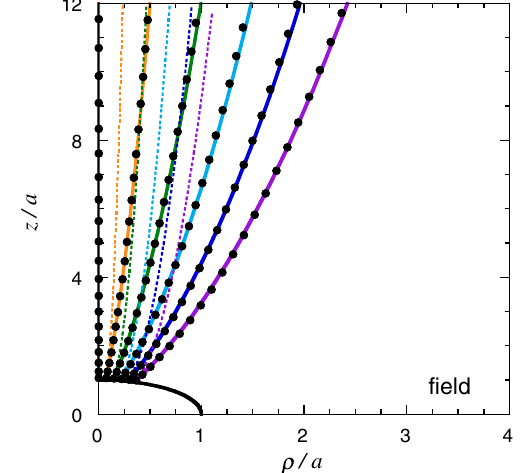
FIG. 15. Same as Fig. 14 but with the axes adjusted to see trajectories well away from the boss